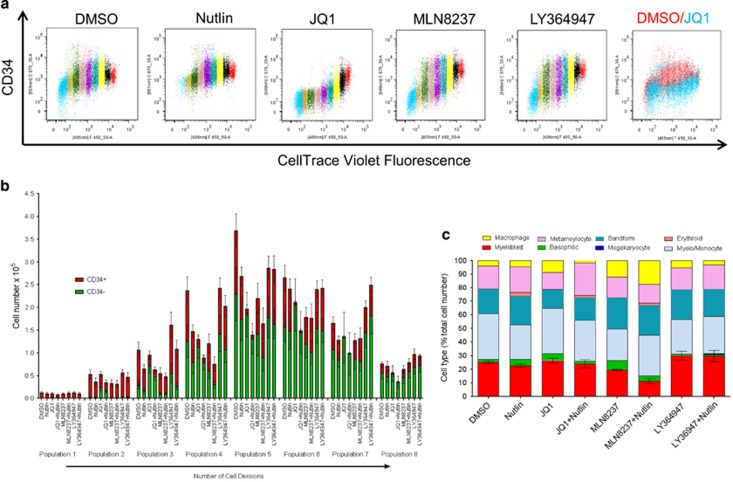
CD34+ cells isolated from JAK2V617F patients were stained using CellTrace. The effect of inhibition of MYC (250 nM JQ1), aurora kinase (50 nM MLN8237) and TGFβ receptor (10 μM LY364947) in combination with the activation of p53 (500 nM nutlin) on cell proliferation and differentiation was assessed over 8 days in liquid culture. (a) Representative flow cytometric analysis of CD34 expression in relation to cell division. Each colour represents a cell division. (b) Amalgamated results of the effects on cell division and CD34 expression (mean±s.e.m., n=8). (c) Cells were stained with May-Grunwald-Giemsa and morphology assessed. Data are expressed as the mean (n=3) for each cell type categorised as a percentage of the total cells. For presentation purposes error bars (s.e.m.) are shown for the number of cells identified as myeloblasts only.